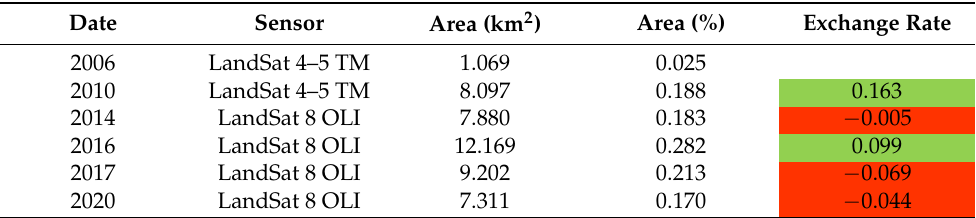
Table 3. Synthetic table of the evolution of water surfaces between 2006 and 2020 in the region of Essaouira, as calculated using the normalized difference water